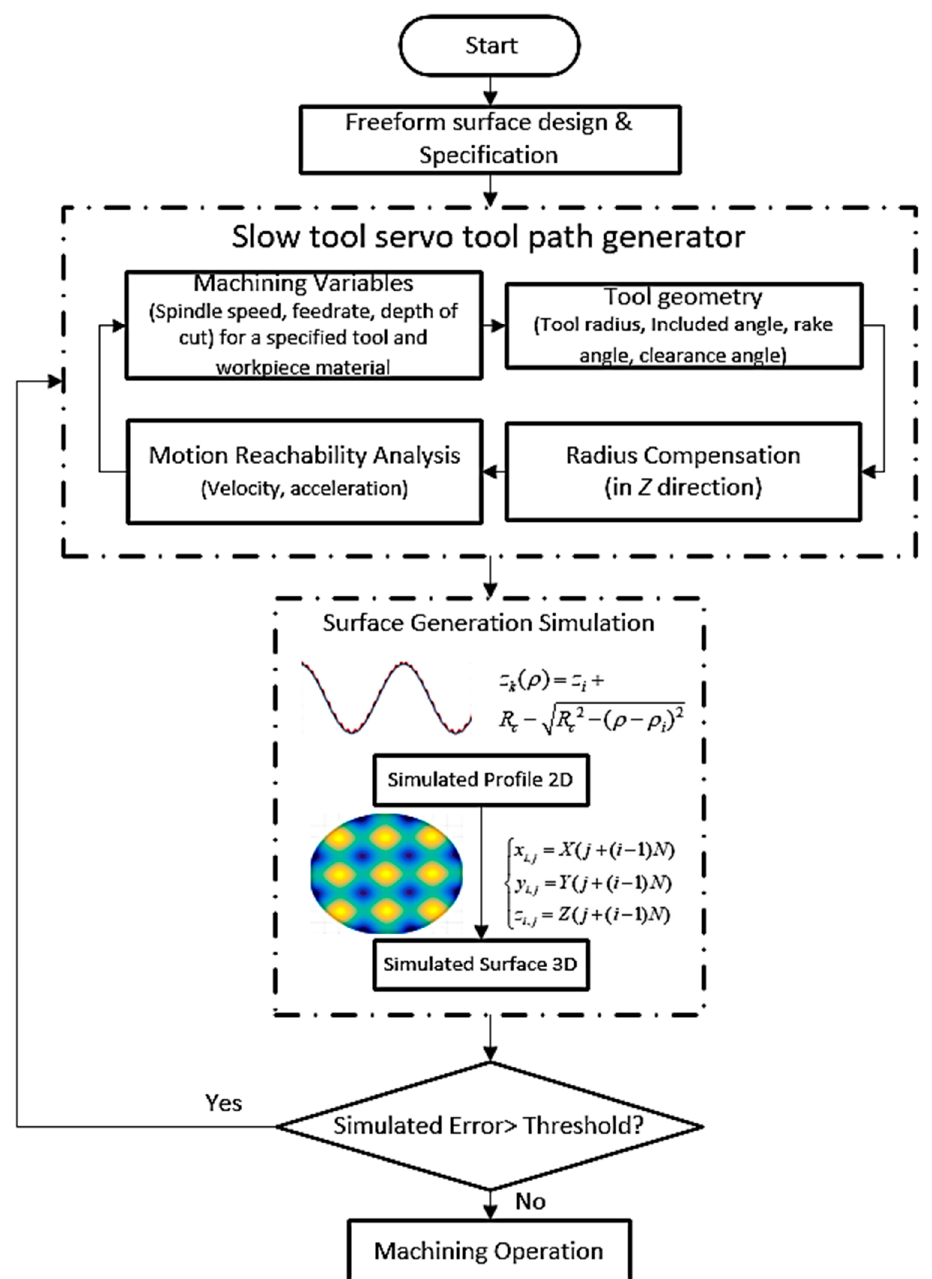
Figure 1. Workflow for slow tool servo (STS) tool path generation.